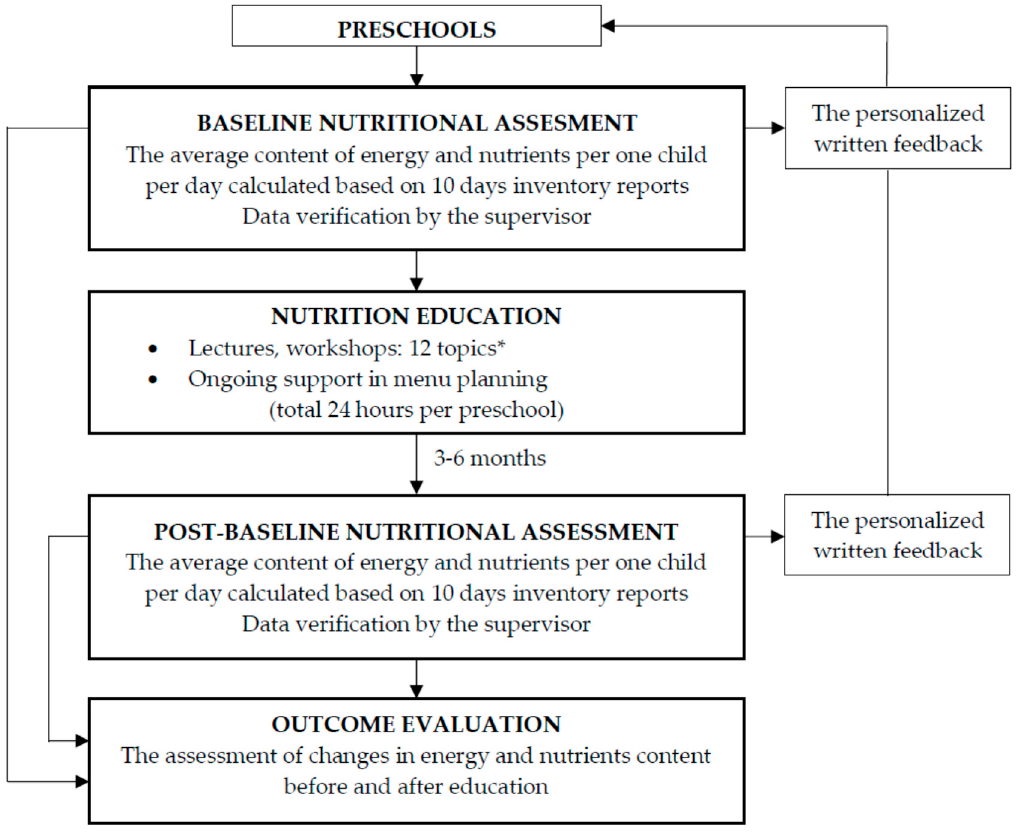
Figure 2. The study design for analyzing the effectiveness of education on the quality of menus in preschools . * The topics of lectures/workshops included 1. General recommendations of balanced nutrition, 2. Water and its role in children’s diets, 3. Sugar in children’s diets, 4. How to deal